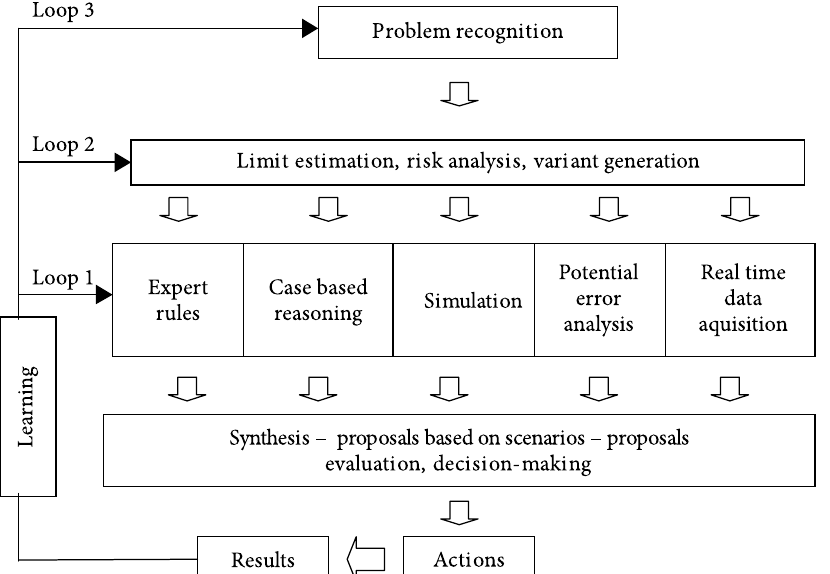
Fig. 2 . The general idea of a hybrid advisory